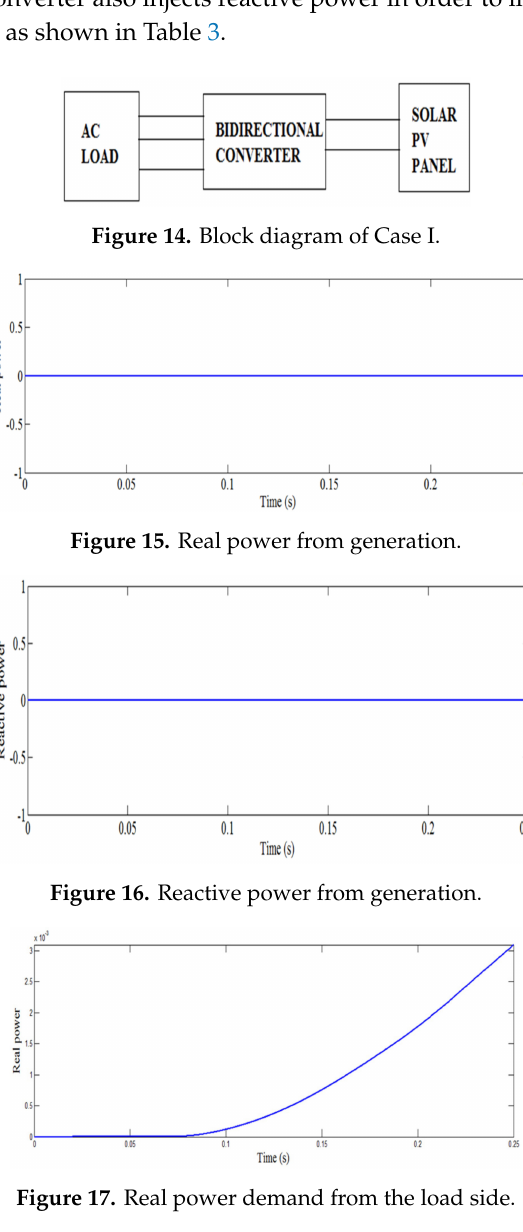
Figure 17. Real power demand from the load side.